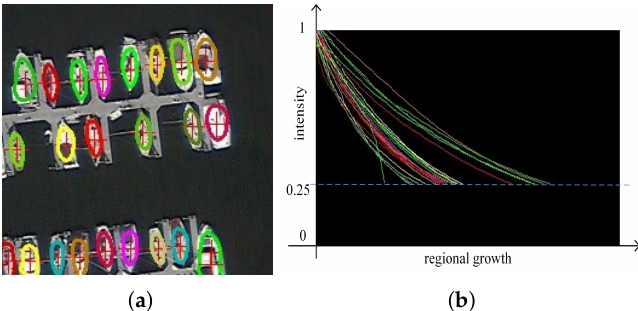
Figure 6. Visual demonstration of Region Fitting Algorithm (RFA) algorithm. ( a ) is a graph of candidate edge points superimposed with multiple objects. ( b ) is the average intensity of the points in the queue during regional growth, and each of the different colored curves corresponds to an object in ( a